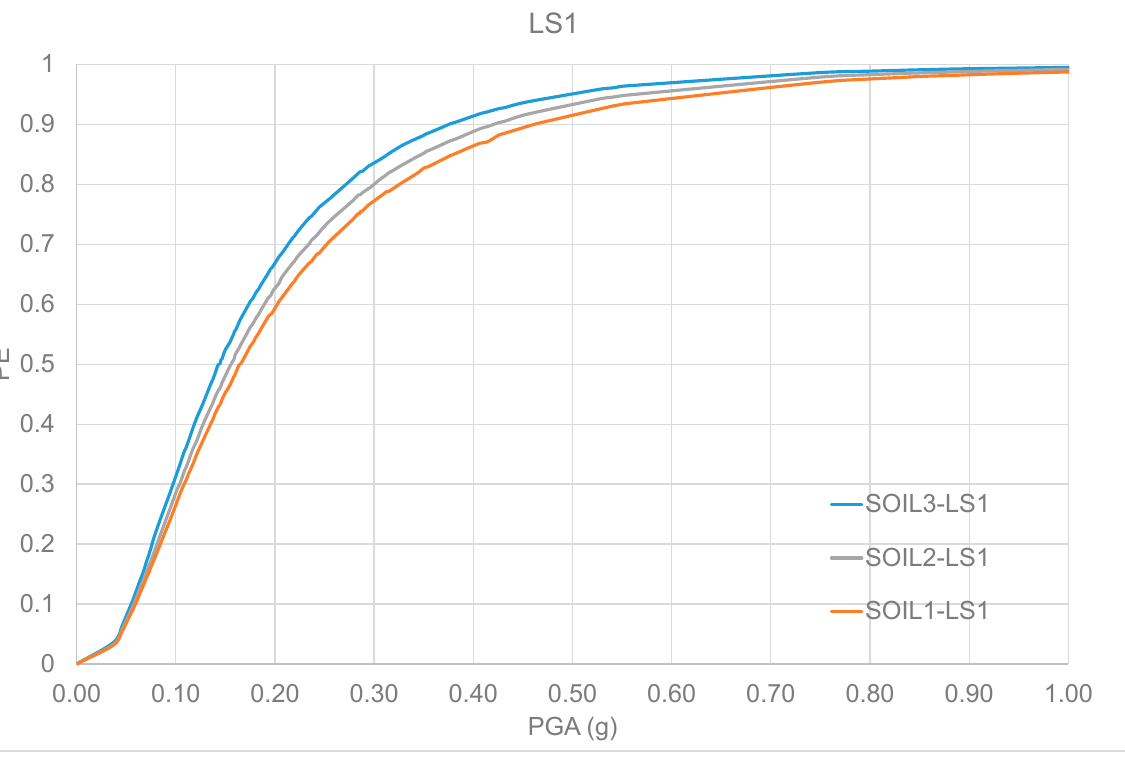
Figure 10. Fragility Curves: comparison LS4.